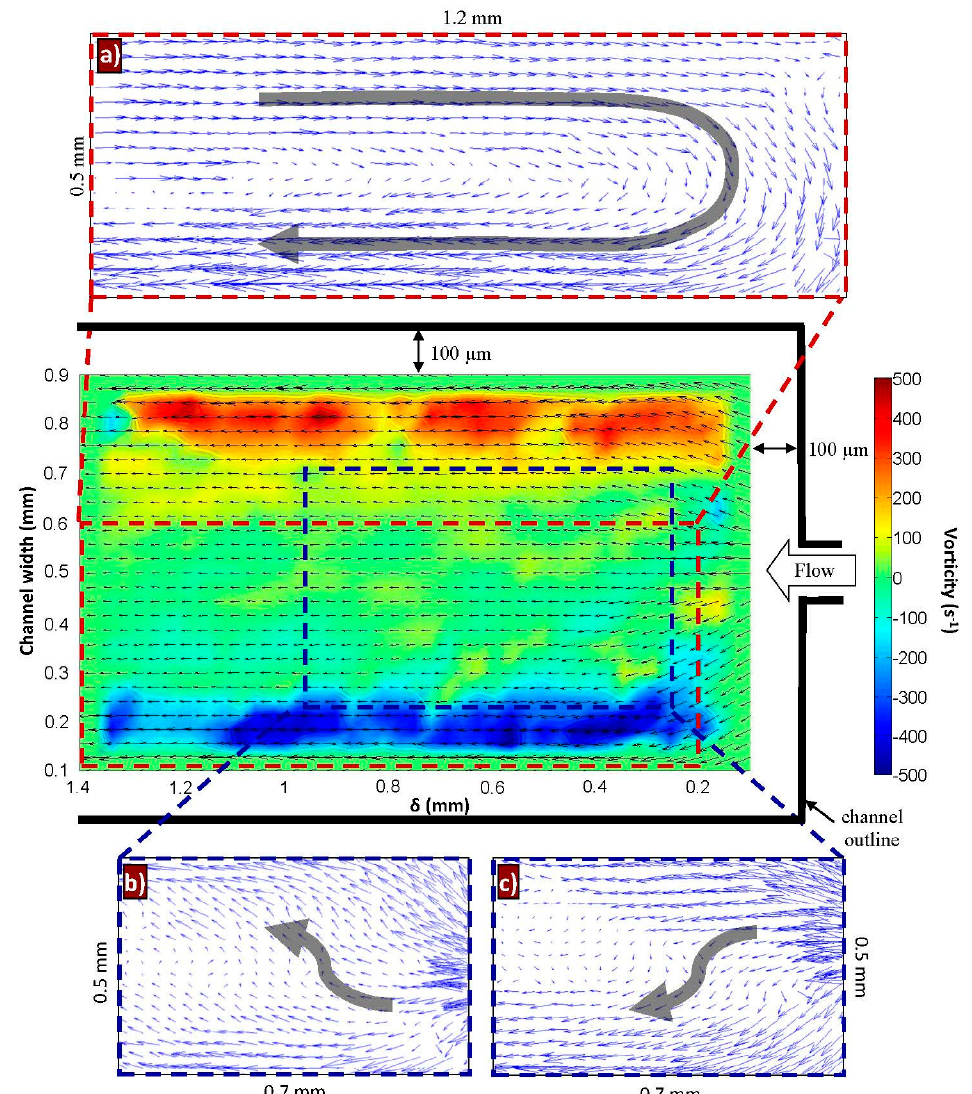
Figure 14. An instantaneous plot of velocity and vorticity (color plot) downstream of the contraction, from δ = 0.1–1.4 mm. Insets a–c show structures (drawn to scale) at various time instances located in different regions, obtained using the Galilean decomposition method with a fraction of the convective velocity removed. ( a ) U − U bulk , ( b , c ) U − 0.6 U bulk (at two different time instants).